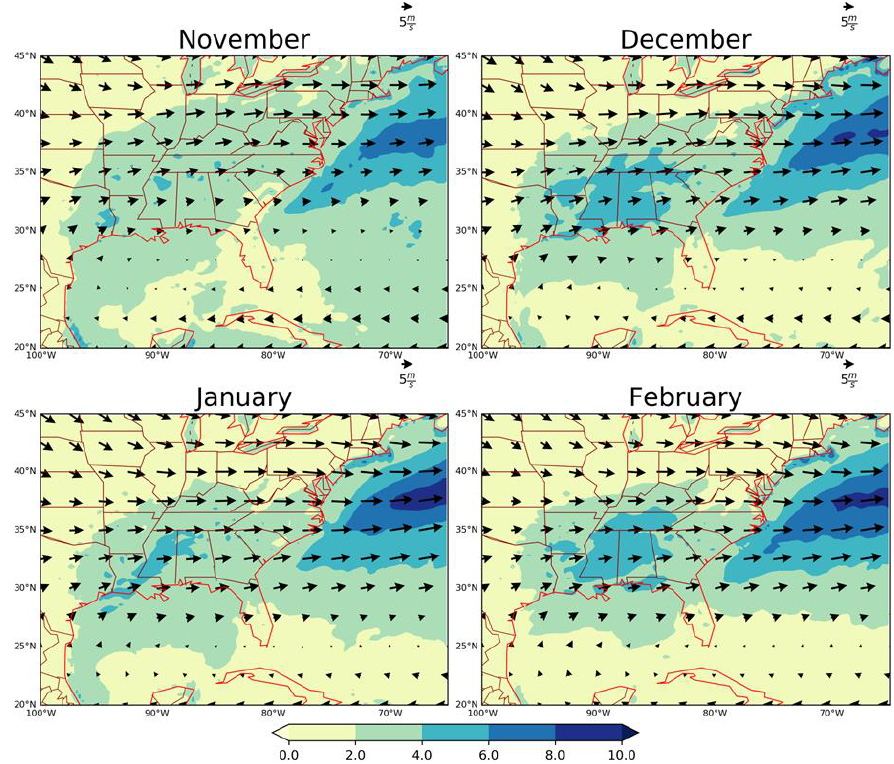
Figure 1. Monthly climatology of precipitation (shades, mm/day) and 850 hPa horizontal circulation (arrows, m/s) in winter in the Southeast U.S. The mean winds are based on the NRP reanalysis of 1948–2022. The mean precipitation is based on the CMORPH (NOAA Climate Prediction Center-CPC Morphing Technique) satellite estimated data for 1998 – 2020.